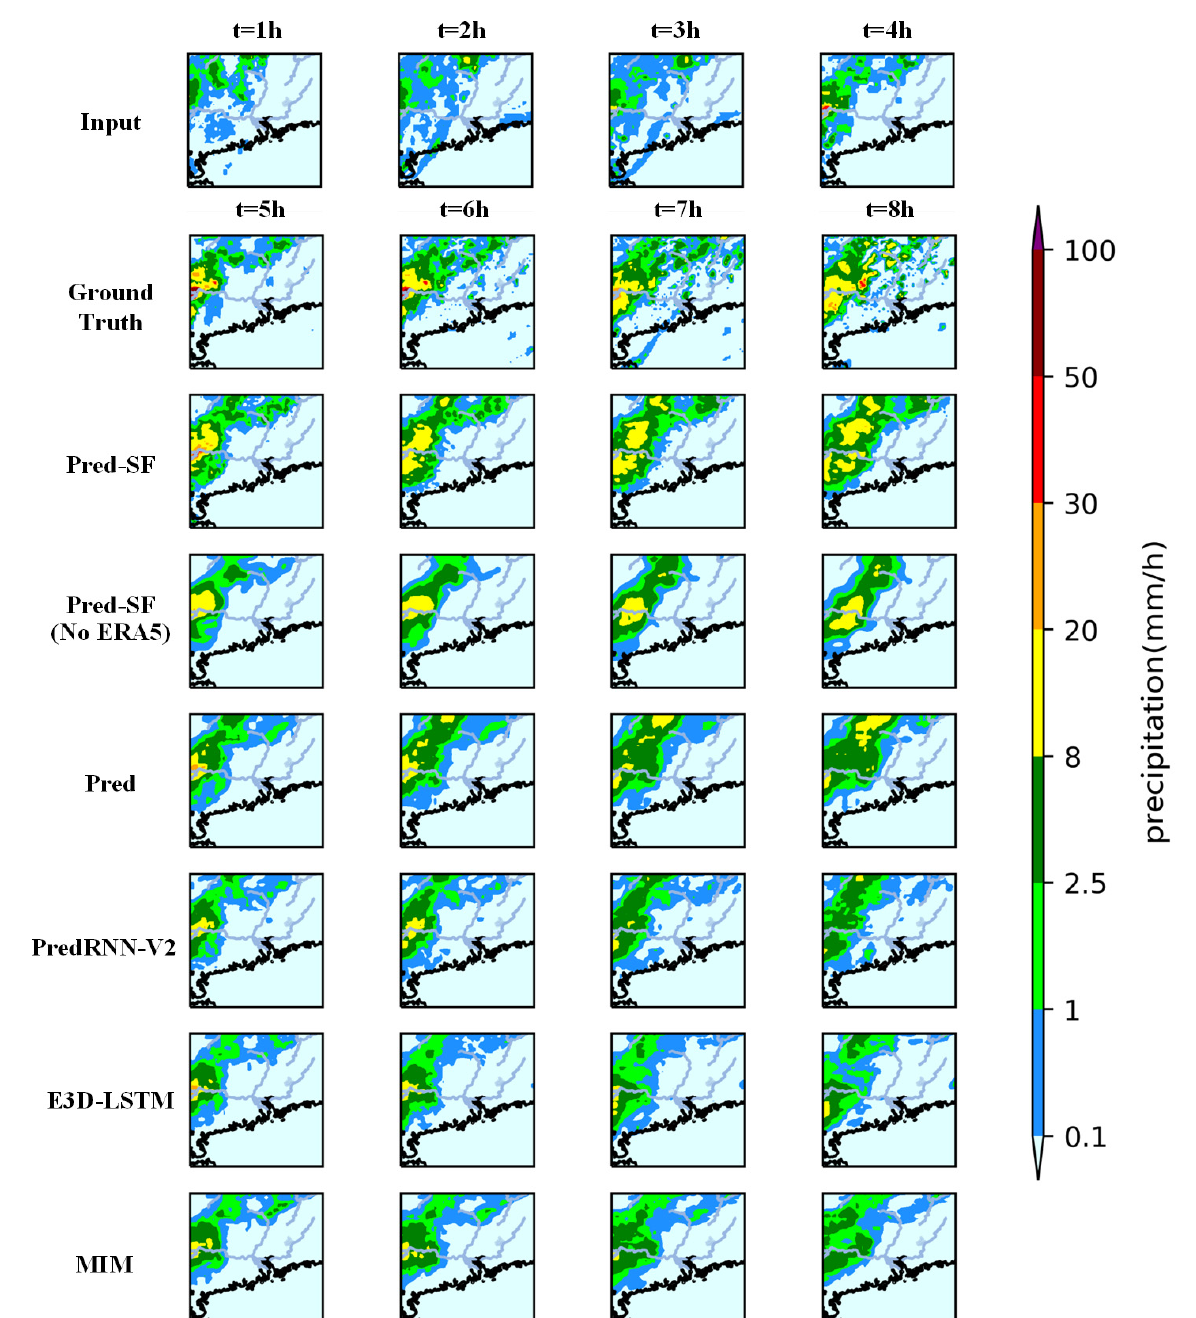
Figure 7. The precipitation prediction results of the six groups of models for 4 consecutive hours (4 time steps) are shown in the figure. The first row is the input, the second row is the ground truth and the following three rows are the output results of the three groups of models.